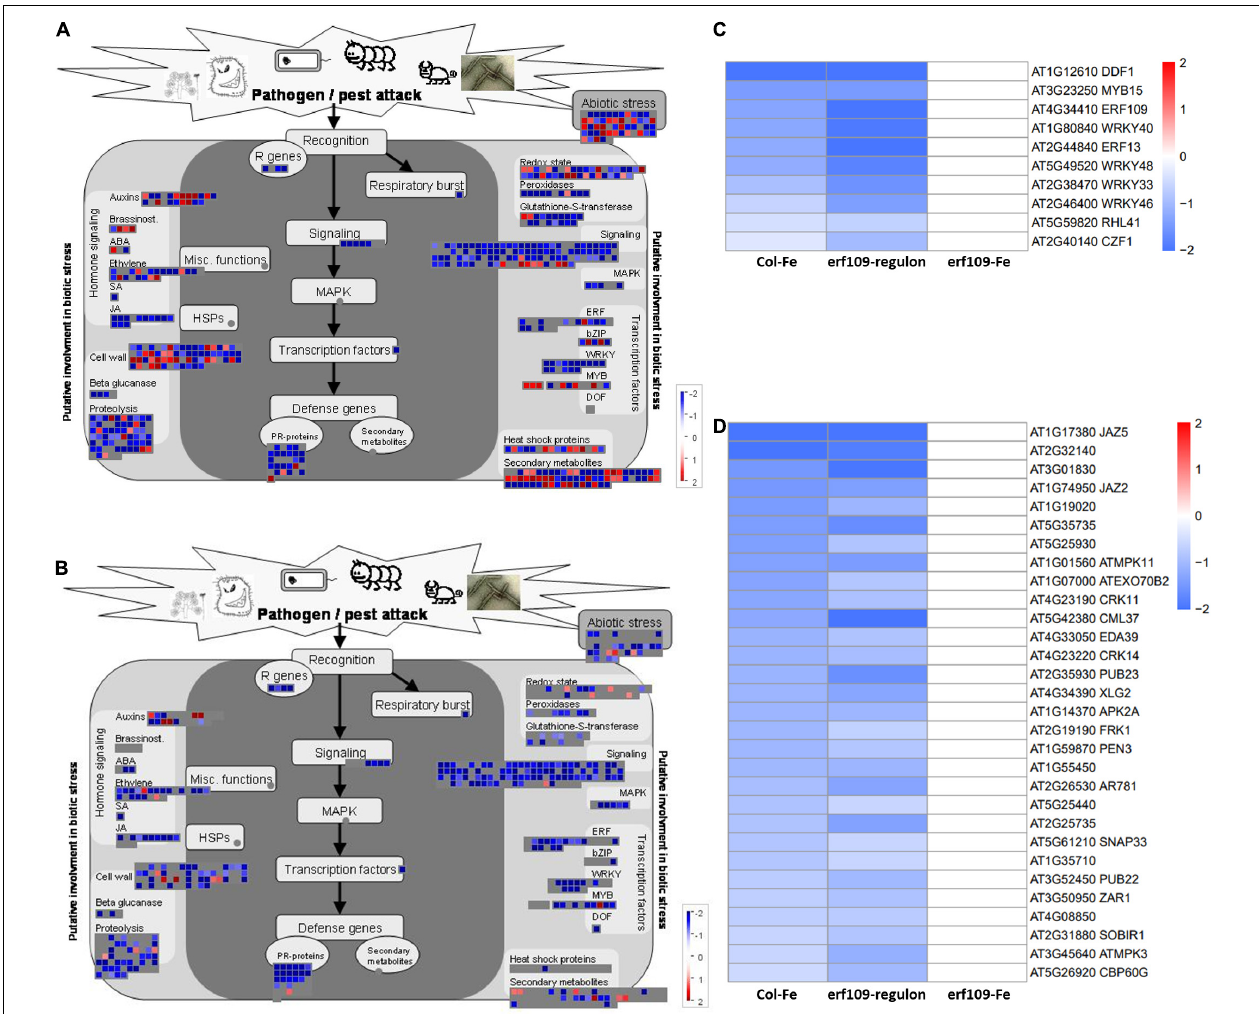
FIGURE 4 | Functional visualization of DEGs involved in pathogen defense. (A) Col-Fe, (B) erf109 -regulon. Graphs were generated with MapMan software (Thimm et al., 2004). Heatmap depicting log2 fold-changes of the transcription factors (C) and other functional DEGs (D) in group 1. Log2-fold changes of DEGs are labeled by color: white, no significant changes; red, up-regulated, blue: